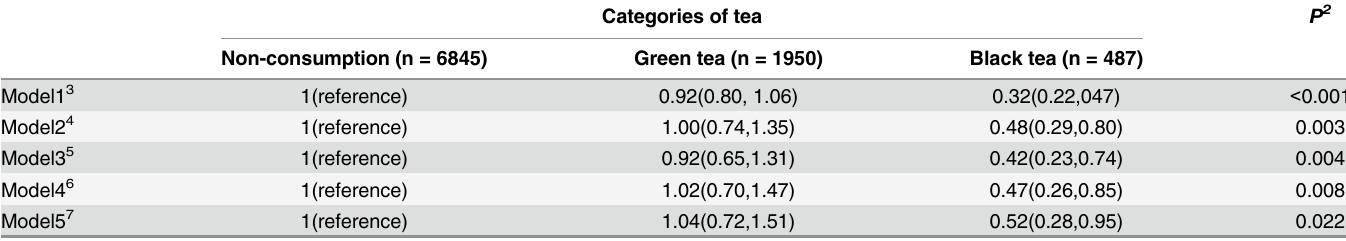
Table 4. Logistic regression models fitting results of the association between tea categories and cognitive impairment 1 .